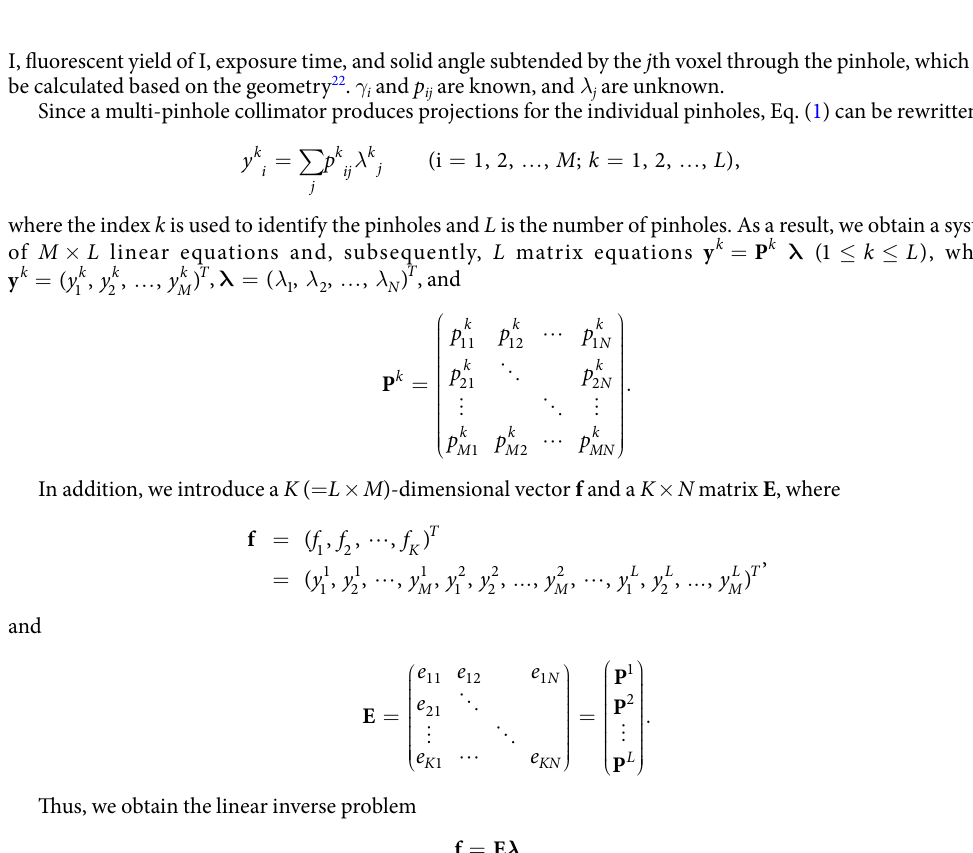
Figure 4. Photograph of the mp-FXCT constructed at beamline ARNE-7A at